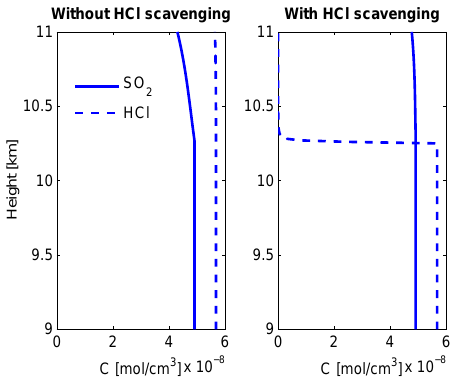
Figure 4. SO 2 and HCl vertical profile. Left panel: without HCl scavenging (e.g., very low halide concentration in sulfur rich plumes); right panel: with HCl scavenging (e.g., HCl-rich plumes). Note that only the height > 9km is plotted